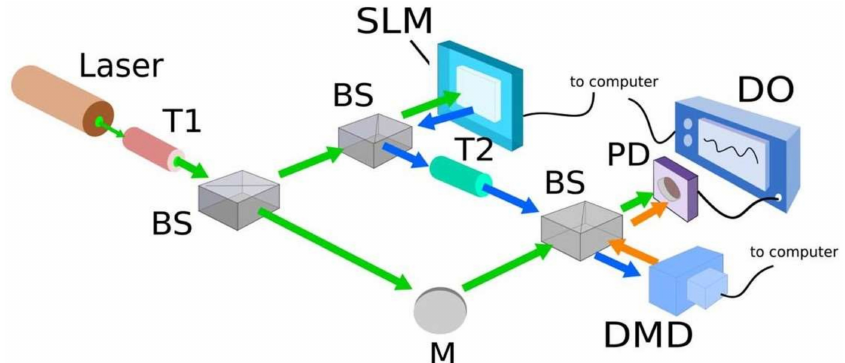
Figure 3. Experimental setup to measure the angular velocity of simulated particles moving along a circular trajectory based on RDE. T1~2: Telescope, BS: Beam splitter, SLM: Spatial light modulator, M: Mirror, PD: Photoelectric detector, DMD: Digital micromirror device, DO: Digital oscilloscope. Adapted with permission from ref. [21].